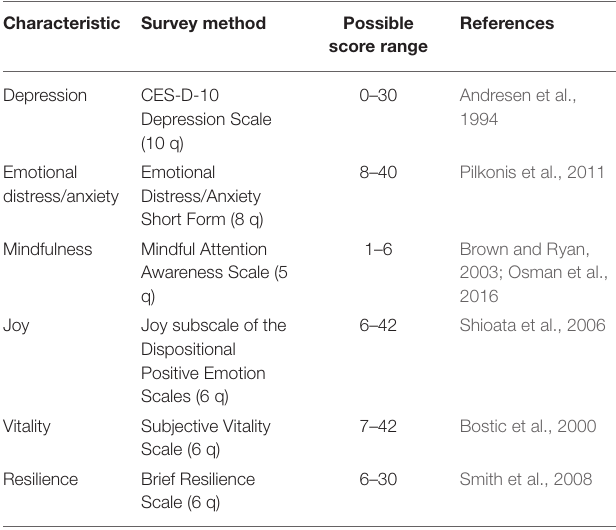
TABLE 1 | Validated surveys and scoring